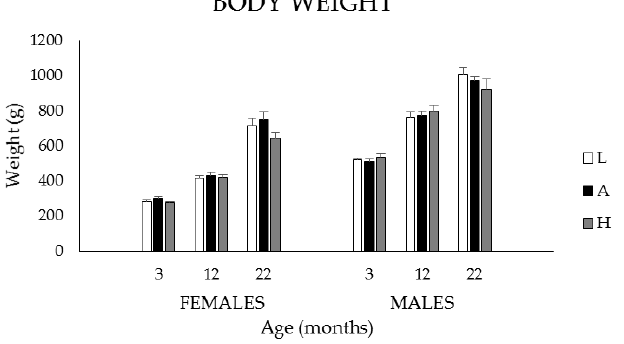
Figure 1. Mean body weights of 3-, 12-, and 22-month-old male (M) and female (F) Sprague–Dawley rats fed the L, A or H diets throughout their lives. Based on the 3-way ANOVA analysis, body weights increased with age in both M and F ( p < 0.001). At all ages, body weights were higher in M than in F ( p < 0.001) but were not affected by diet ( p = 0.258), a finding confirmed by the individual one-way ANOVAs conducted at the group level. Values are expressed as mean ˘ SEM. (3 months F: n = 16/diet gp (group); M: n = 16/diet gp; 12 months F: n = 15–16/diet gp; M: n = 16/diet gp; 22 months F: n = 6–7/diet gp; M: n = 7–9/diet gp).